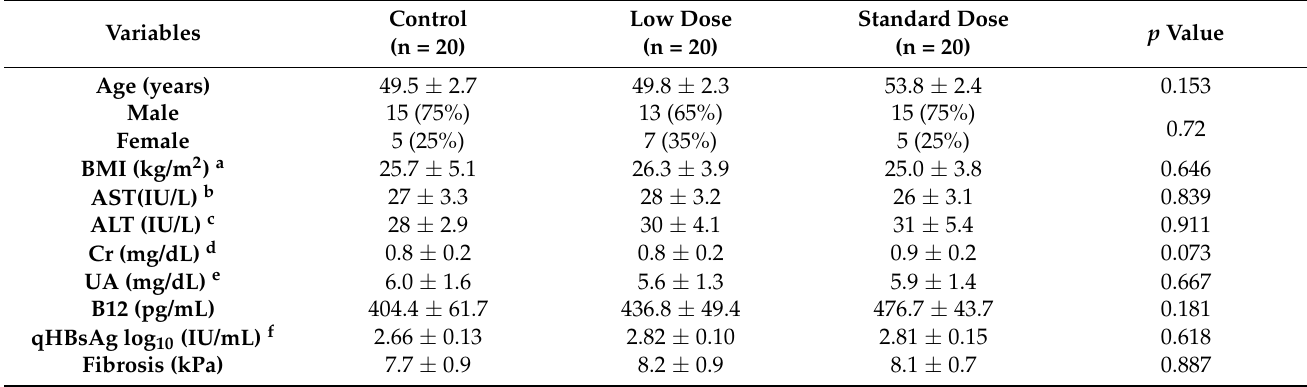
Table 1. Patient demographic and baseline